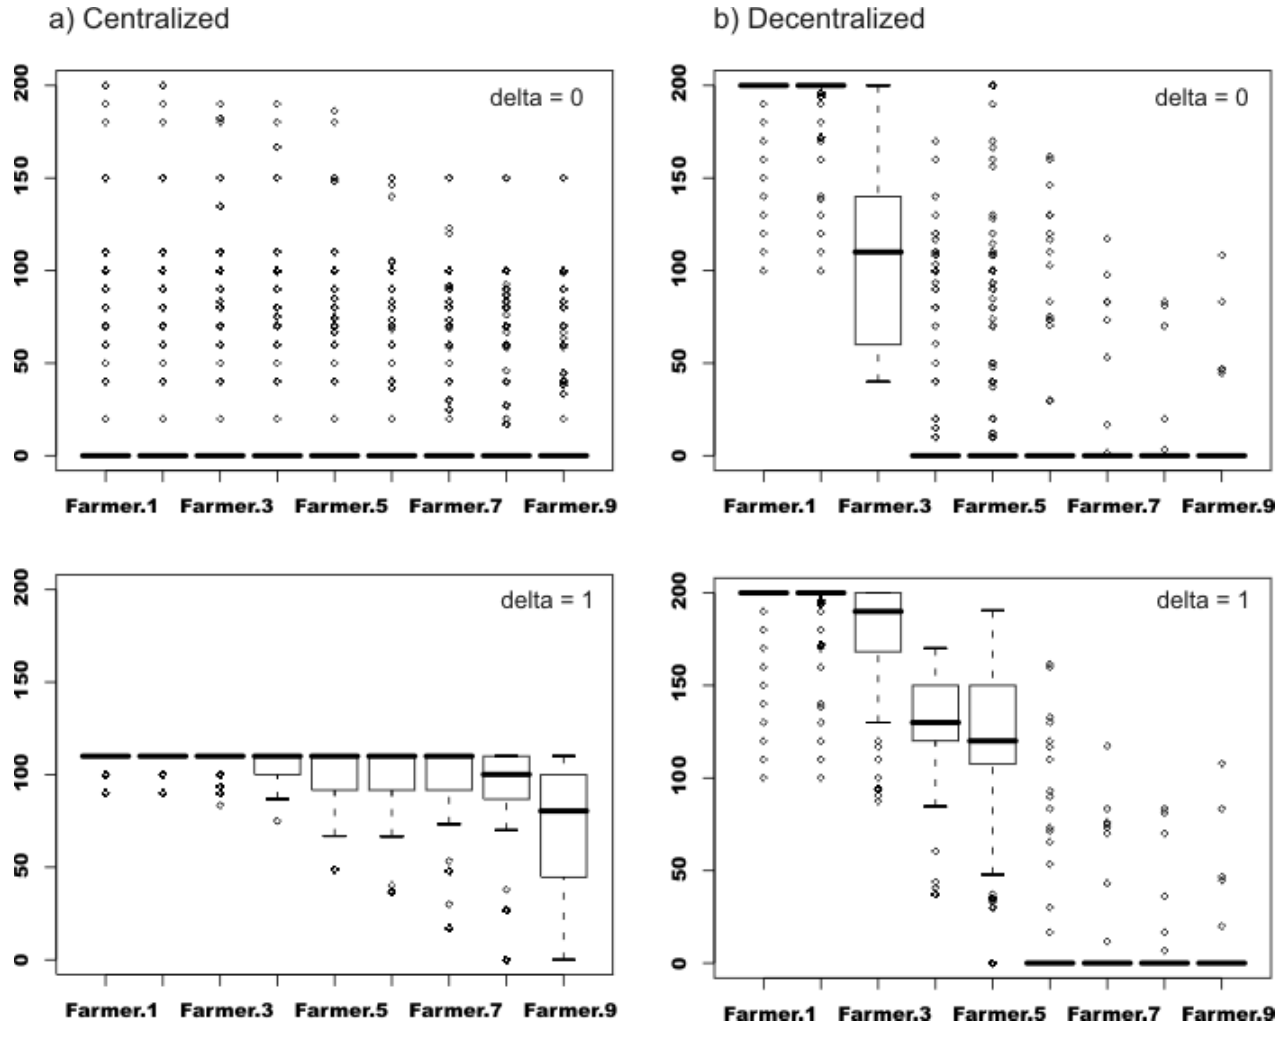
Fig. 8. Annual yields/farmer for delta = 0 and delta = 1 for the a) centralized and b) decentralized models without fishing. Parameter values are the same as in Fig. 6, i.e., max. number of fields– centralized: 180, maximum number of fields/farmer–decentralized: